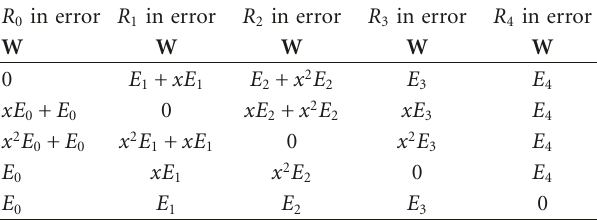
Table 3: The error locator matrix, W , for a single packet in error for the (5,3,3) systematic